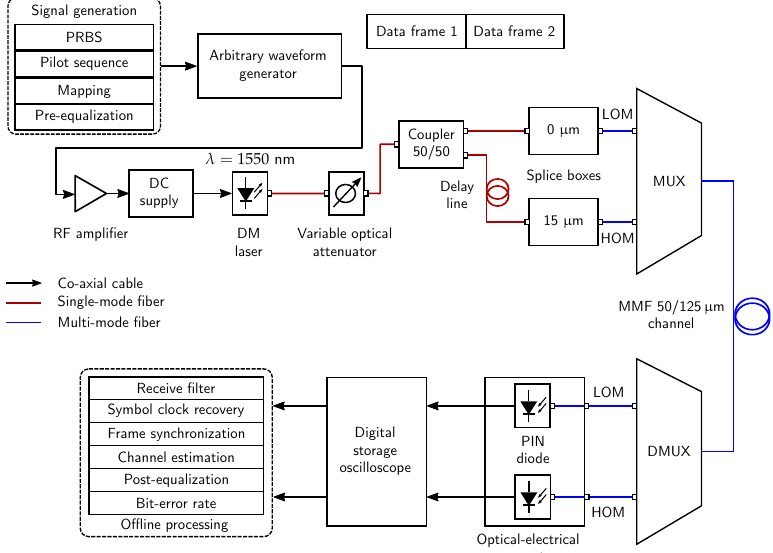
2 ) MIMO system 2 ) MIMO system × ×